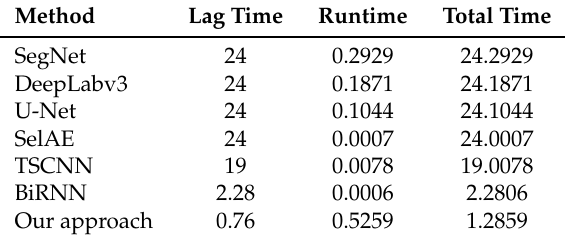
Table 7. Comparison of runtimes (in seconds). The column lag time represents the time to wait until the current scanline is classified. This lag is because many algorithms need to use not only the current scanline and the previous ones, but also the following scanlines to have more context. The runtime column shows the time that the algorithm takes to yield a response once all the information is provided. The last column shows the sum of times, which corresponds to the time perceived by the user in getting a